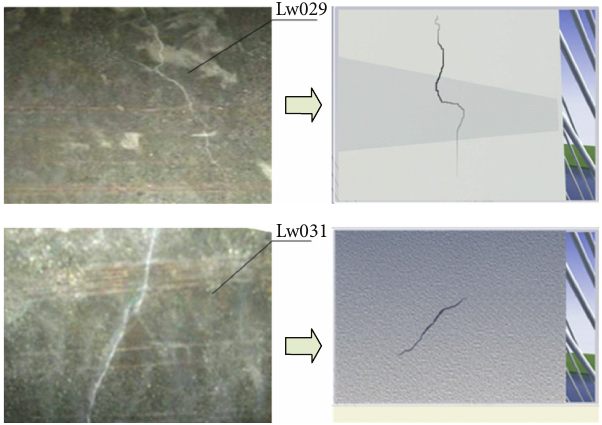
Figure 15: Comparison of tower no. 1 between man-operated detection and monitoring using the plug-in of recurrence of